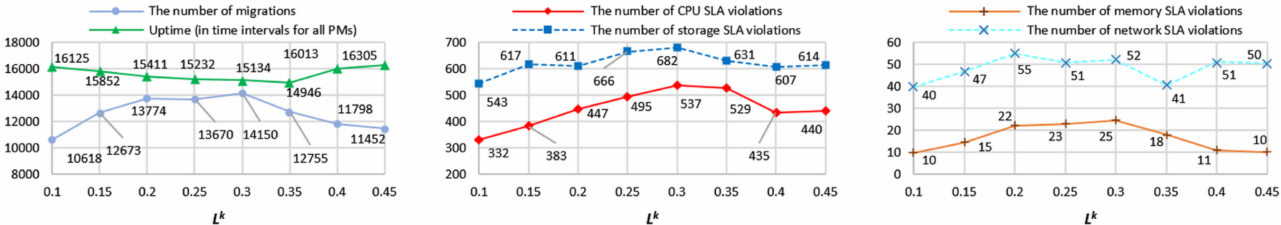
Figure 4. The effect of L k on the quality metrics for power consumption